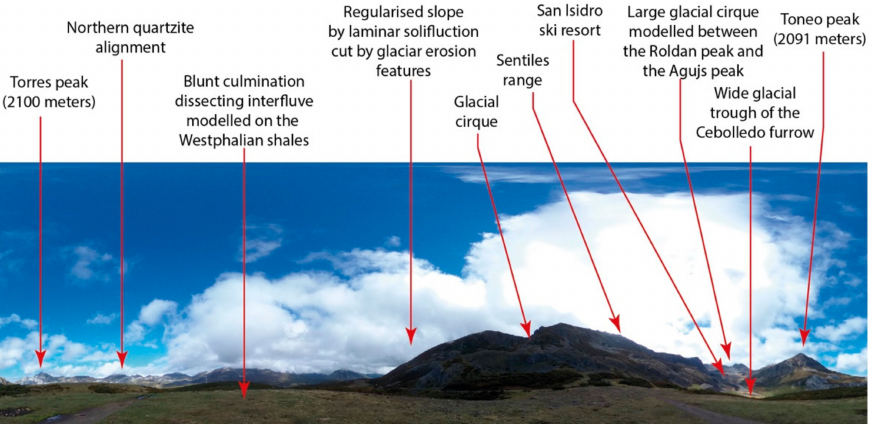
Figure 16. 360 ◦ photograph from the sixth POI. Photograph by the authors. Focus with camera on Figure through Onirix site or use the link